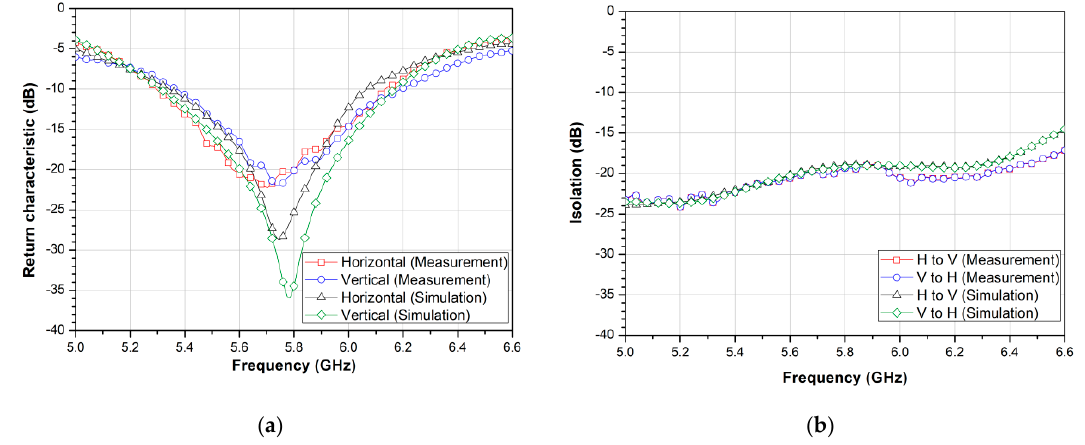
Figure 8. Simulated and measured ( a ) return and ( b ) isolation characteristics.